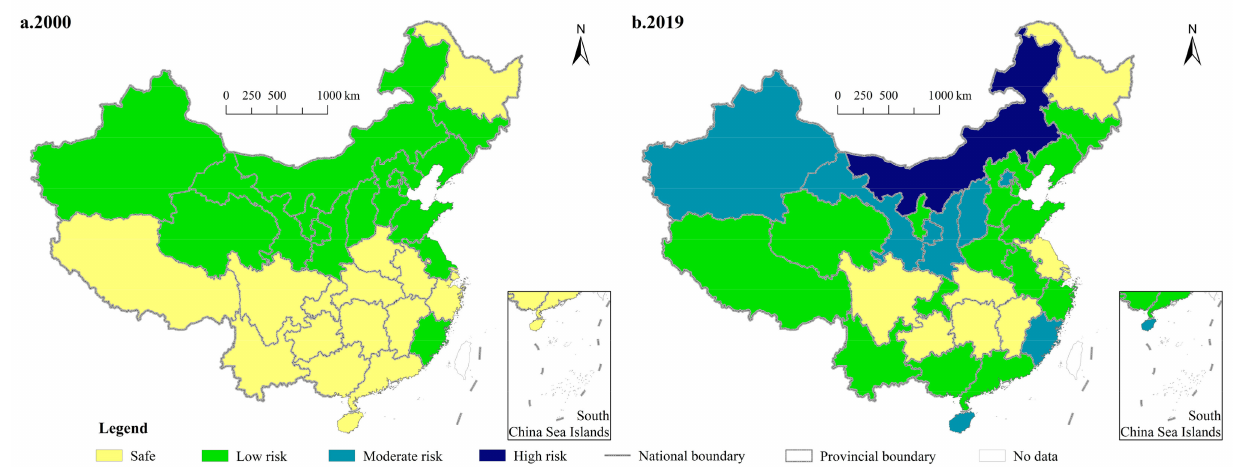
Figure 4. Spatial pattern of the environmental risks of China’s CFAI in 2000 ( a ) and 2019 ( b ).